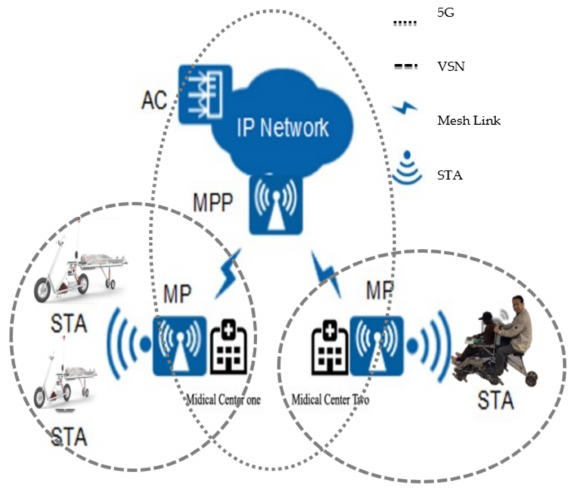
Figure 4. Overall proposed system architecture.